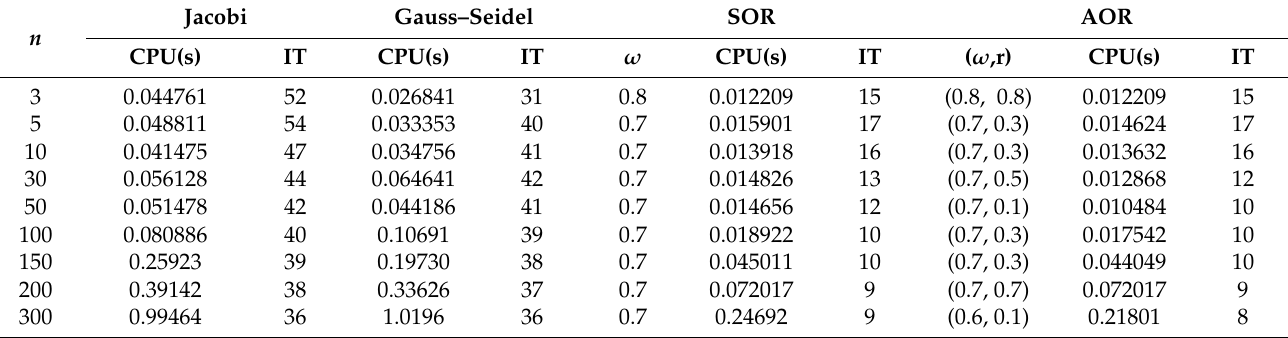
Table 1. The numerical results of Example